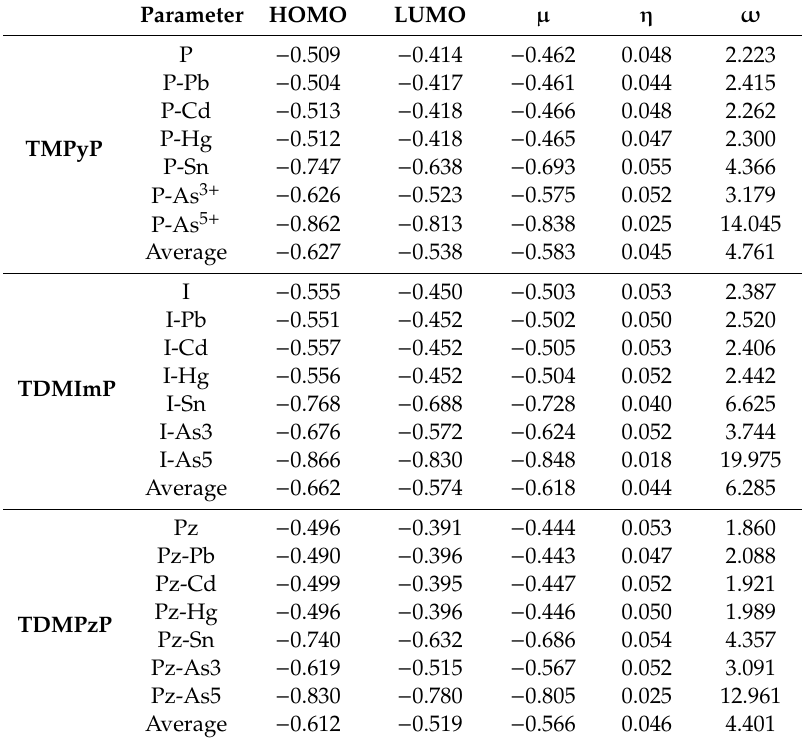
Table 3. Global chemical reactivity descriptor for cationic porphyrin − metal complexes (units in au). Parameter HOMO LUMO µ η ω